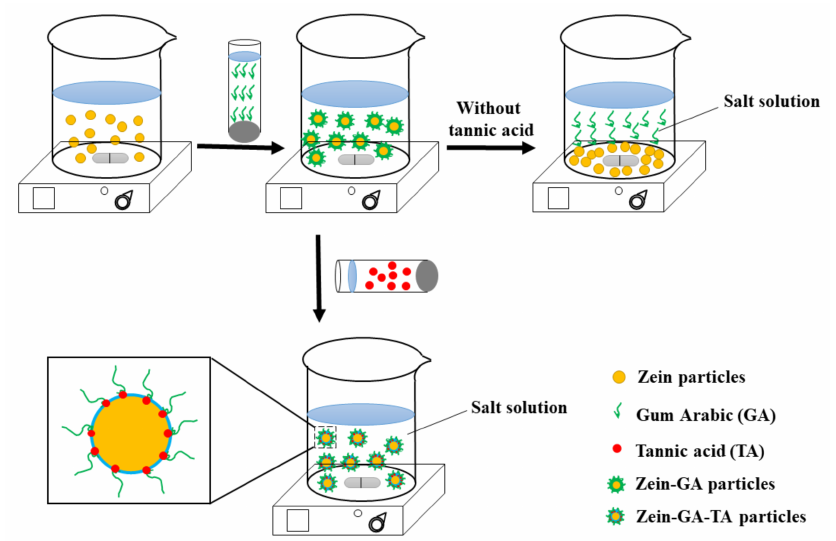
Figure 1. The preparation diagram of the zein–gum -arabic–tannic acid (-zein-GA-TA) gel